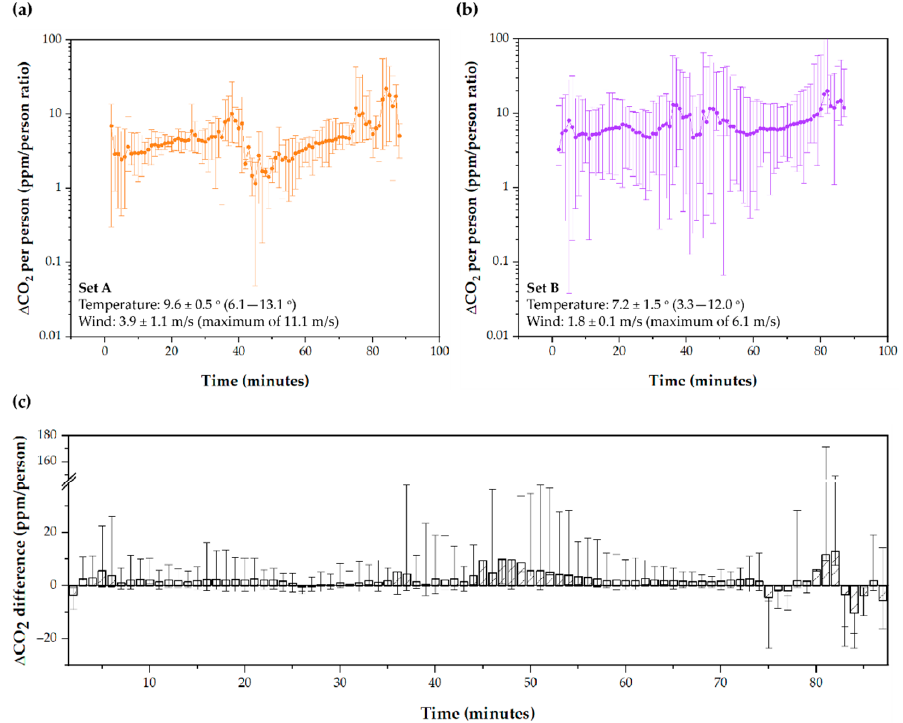
Figure 8. ∆ CO 2 per person ratio (ppm/person) in ( a ) Set A, and in ( b ) Set B depending on time; ( c ) difference between Set B and Set A depending on